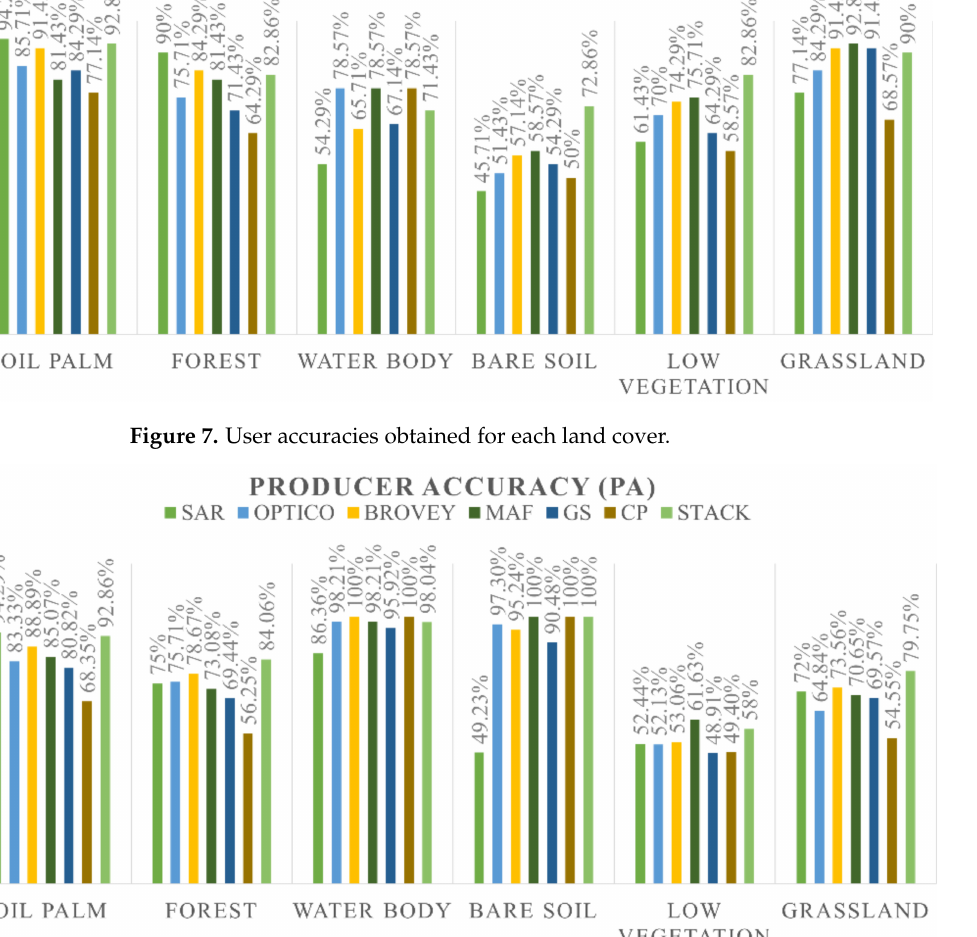
Figure 8. Producer accuracies obtained for each land